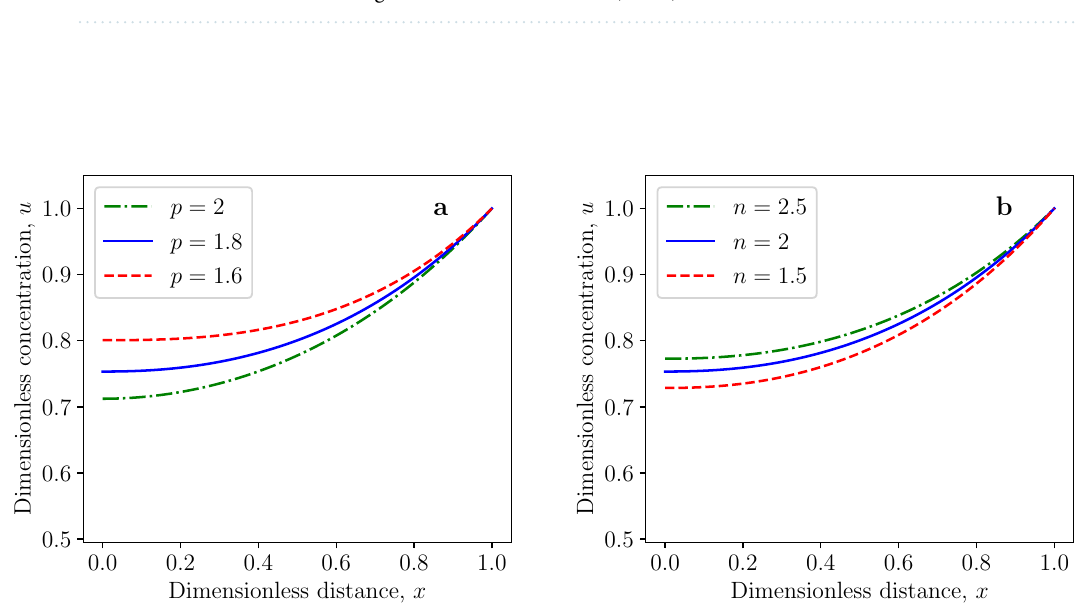
0 . 0 Dimensionless distance, x Figure 5. ( a ) Profiles of dead-core solutions for the first-order reaction ( n Thiele modulus on dead-zone length for first-order reaction ( n